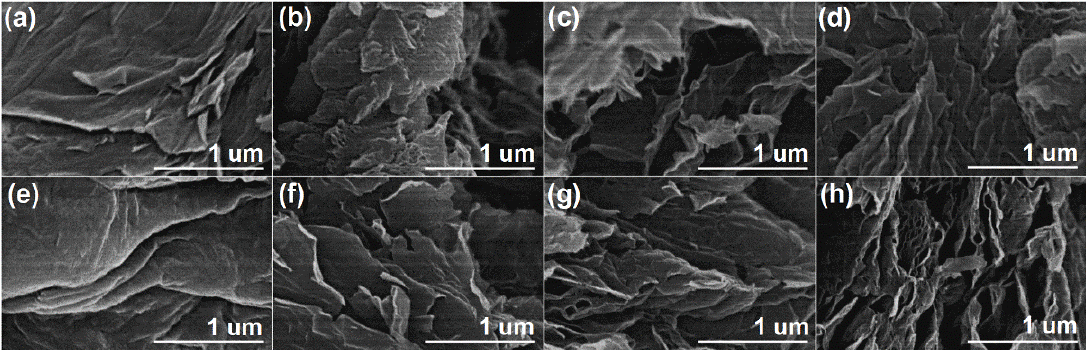
Figure 5. SEM images of GO 1 ( a ), rGO 1 ( b ), rGO 1 _5 ( c ), rGO 1 _10 ( d ), GO 2 ( e ), rGO 2 ( f ), rGO 2 _5 ( g ), and rGO 2 _10 ( h ) samples.